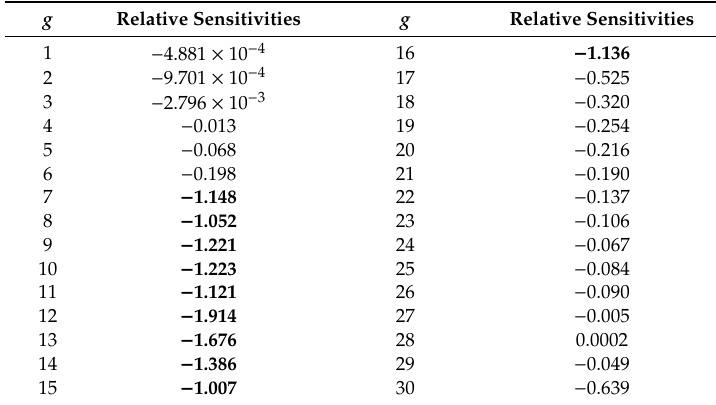
(cid:16) (cid:17) N 2,1 , σ g , g = 1, ... ,30. t ,1